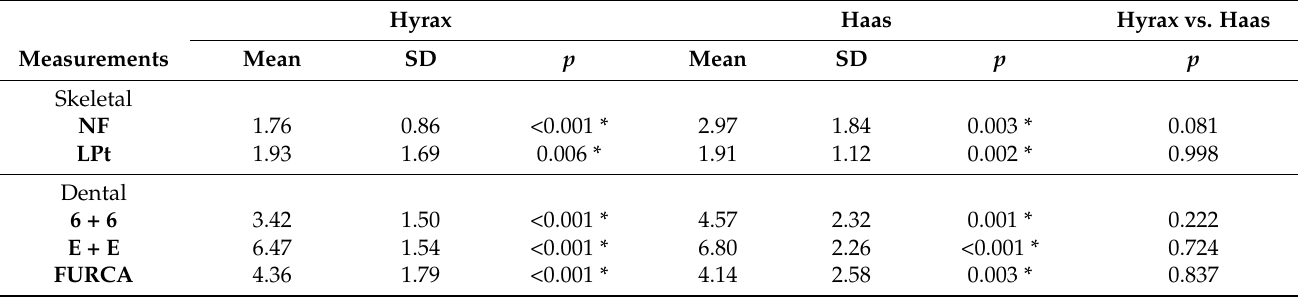
Table 6. Intraclass comparisons between transversal differences (Mean and Standard Deviation) between T0 and T1 and interclass significance (* p <